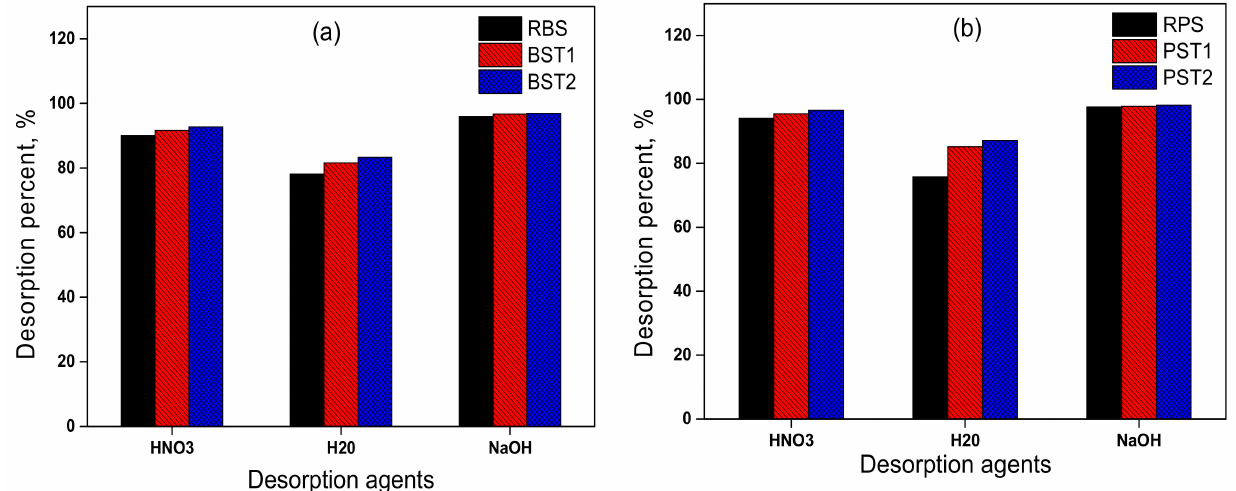
Figure 12. The desorption efficiency in three different media. Percent desorption of IC adsorbed onto biosorbents RBS, BST1, BST2 ( a ) and RPS, PST1, PST2 ( b